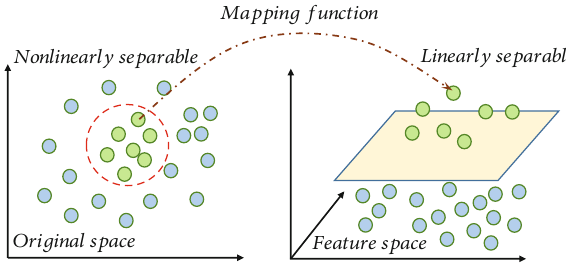
Figure 2: The SVM solution principle.